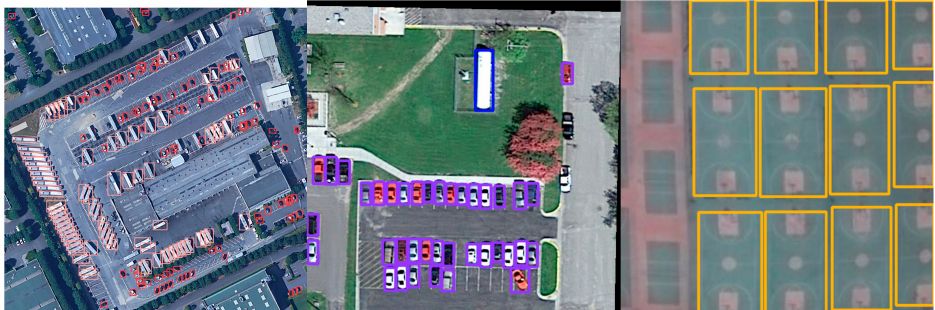
Figure 12. Some detection results of proposed work. Different colors show different